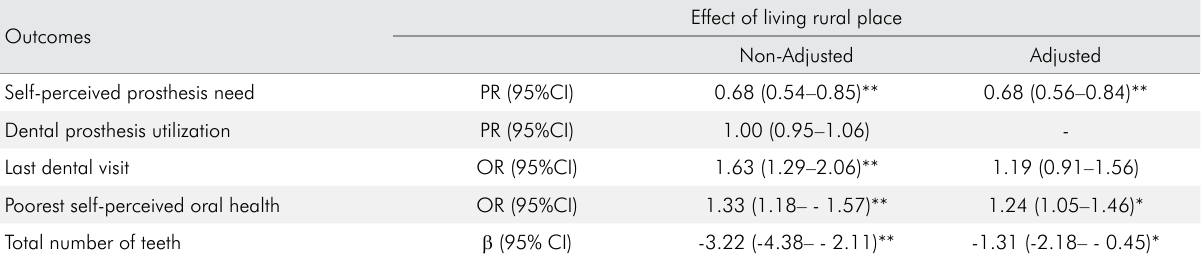
Table 3. Effect of living in rural places in specific oral health outcomes according to specific regression analyses. Crude and adjusted